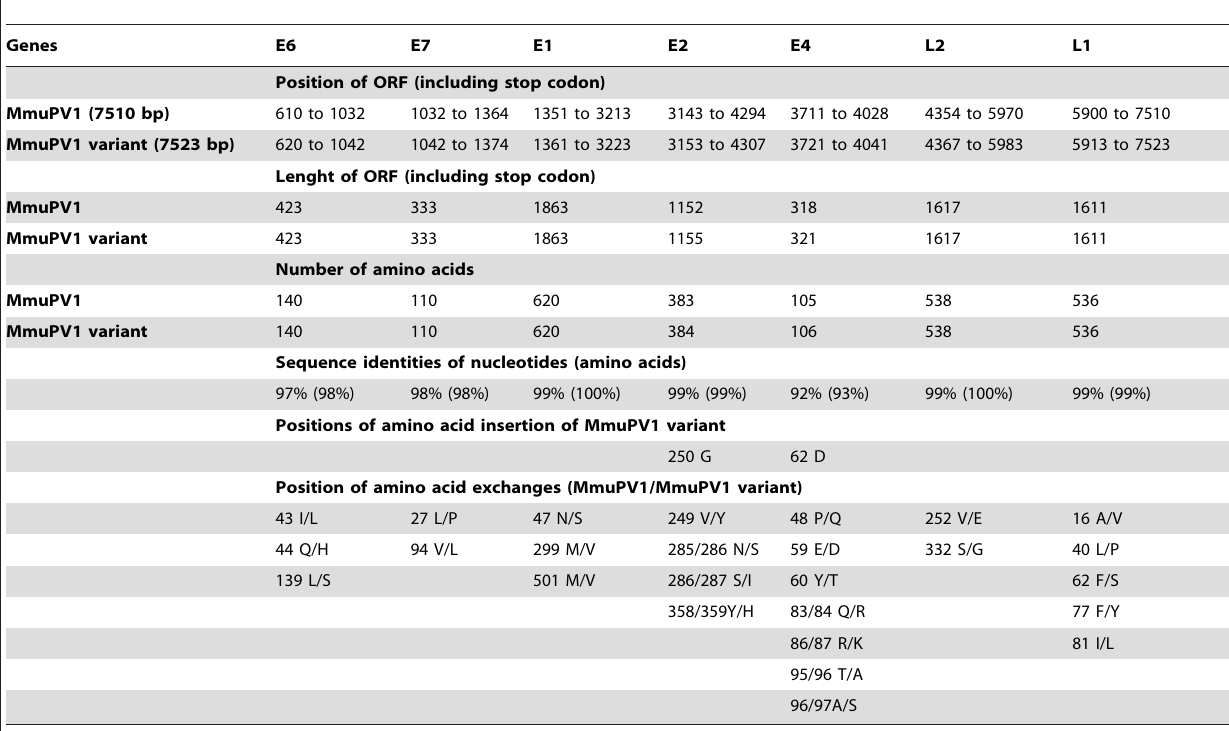
Table 1. Sequence comparison between MmuPV1 and the novel MmuPV1 variant.